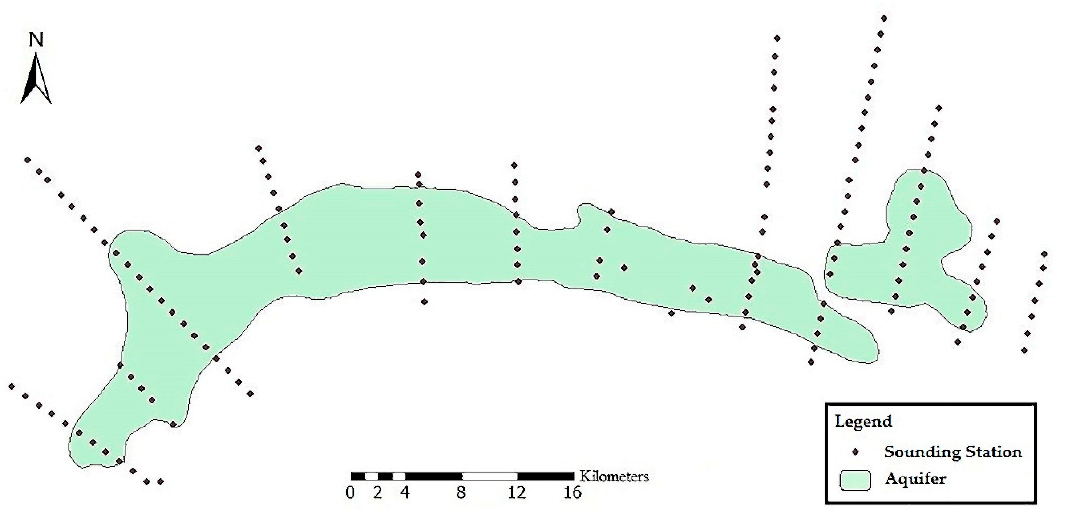
Figure 8. Location of geoelectrical soundings in Birjand aquifer.